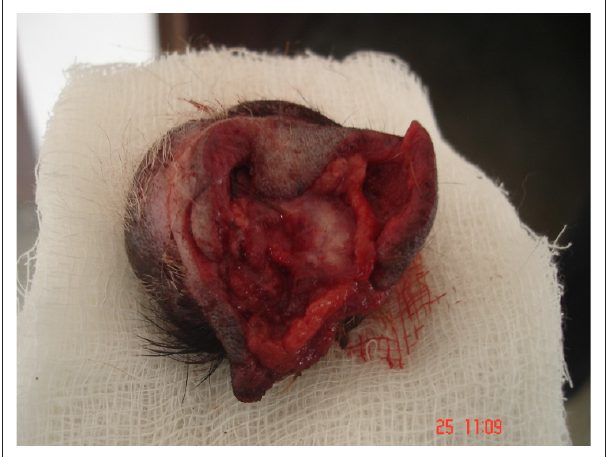
FIGURE 2: The excised